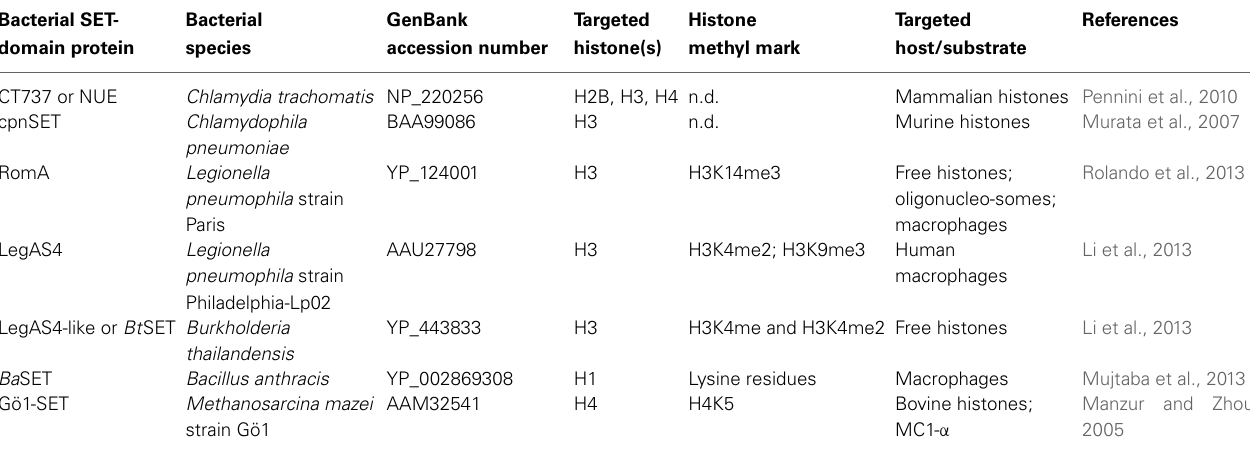
Table 1 | Bacterial SET-domain proteins involved in eukaryotic chromatin modification.